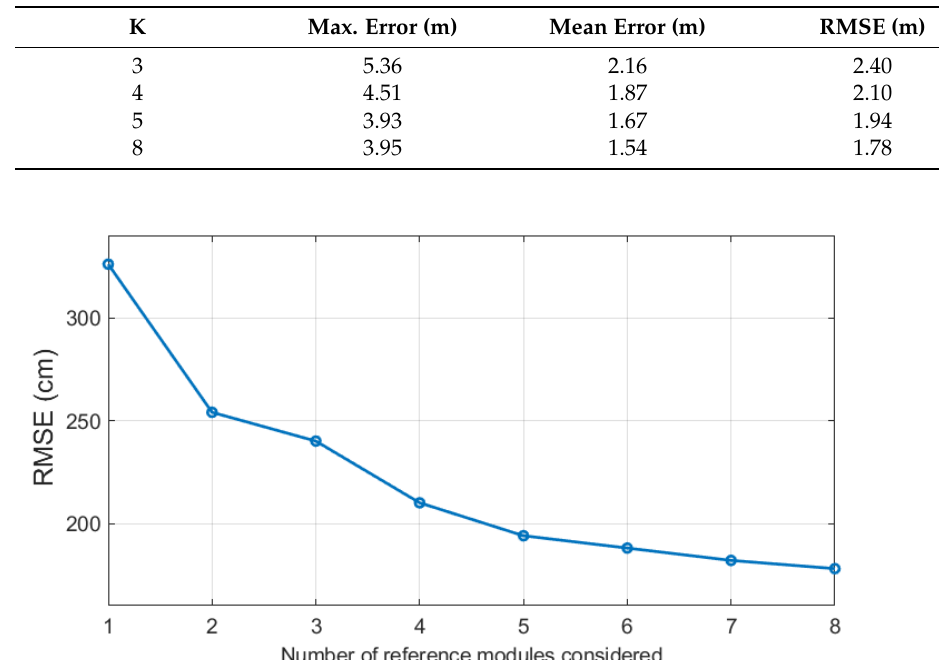
Figure 11. Root mean square error (RMSE) for different numbers of modules of the lowest Euclidean distance considered for the second phase of the proposed localization algorithm.